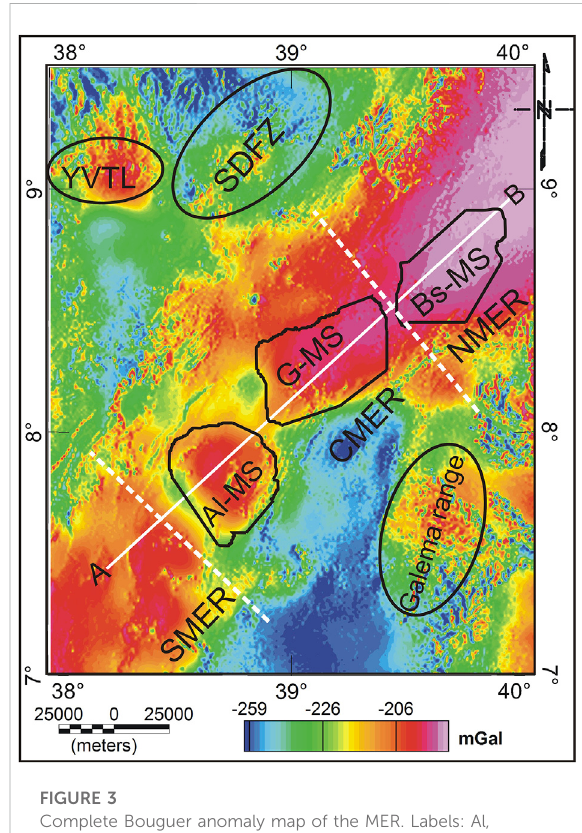
FIGURE 3 Complete Bouguer anomaly map of the MER. Labels: Al, Aluto; TM, Tulumoye; G, Gedemsa; Bs, Boseti; SDFZ, Silte Debrezeyit fault Zone; YVTZ, Yerer Tulu volcano-tectonic zone. The white broken line shows the expected boundary of the Southern, Central, and Northern MER. The curved solid lines represent the off-rift volcanic zones and the irregular polygons represent the magmatic segments along with the MER. The white line along AB is the model (Figure 9) pro fi le line.